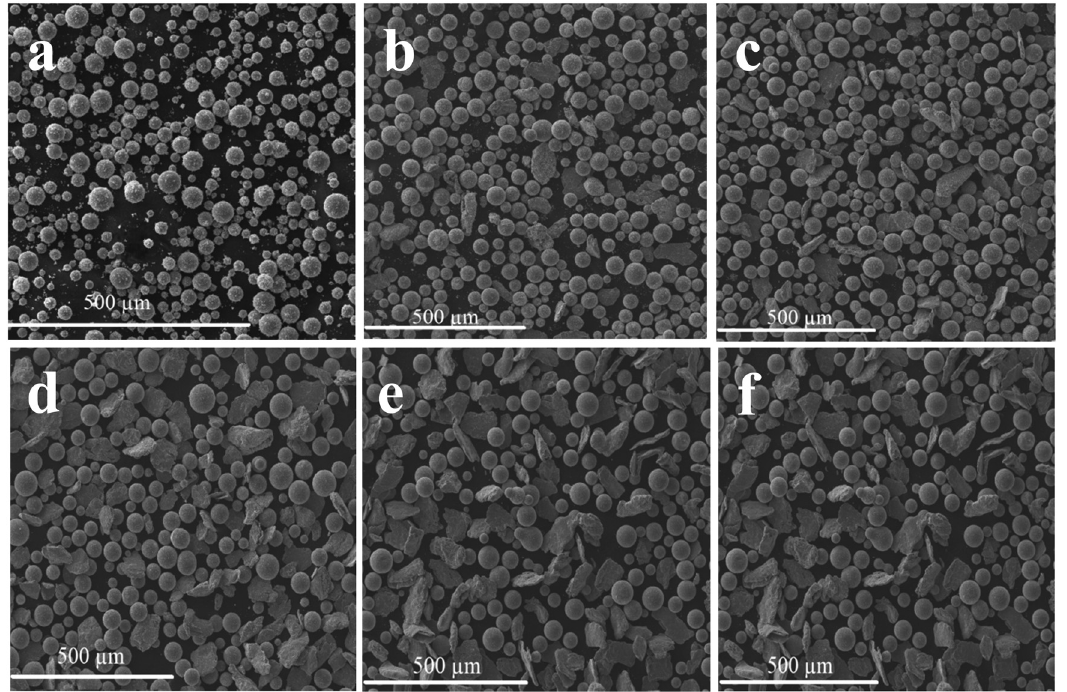
Figure 4: Morphology of the powder in the modes 1 – 6: ( a ) 15 kW, ( b ) 14 kW, ( c ) 13 kW, ( d ) 12 kW, ( e ) 11 kW, and ( f ) 10 kW; feed rate of 28 g · min − 1